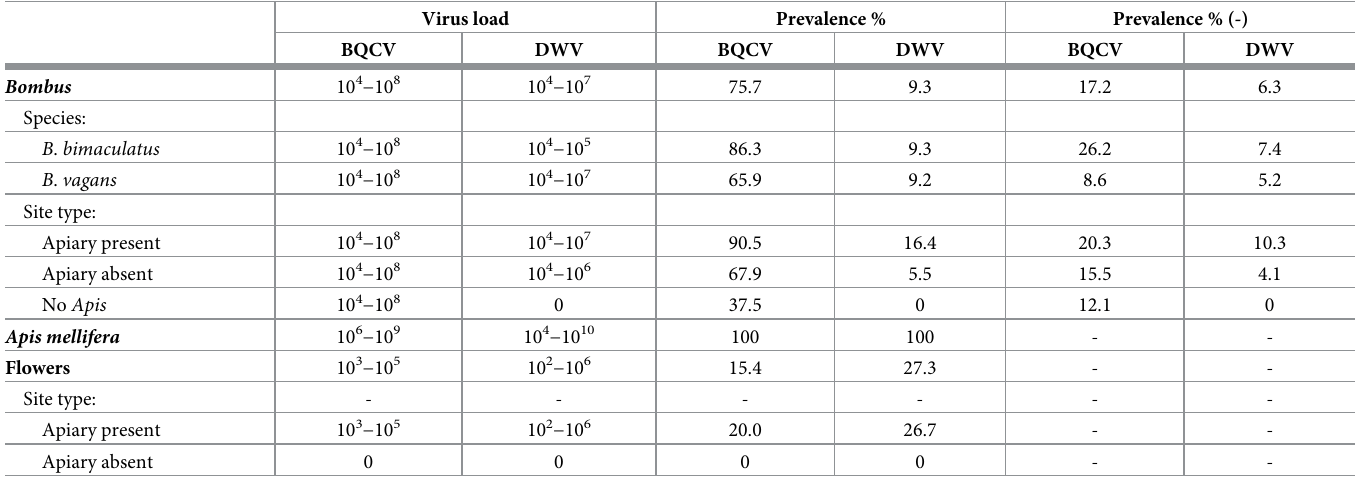
Table 1. Results of virus assays for bumblebees, honeybees, and flowers. Virus loads are presented as the observed range of viral genome copies. Prevalence % is the per- centage of samples positive for a virus. Prevalence % (-) is the percentage of bees in which we detected the negative virus strand, indicative of a replicating infection. Site type ‘No Apis’ are sites without apiaries and with no honeybees observed during